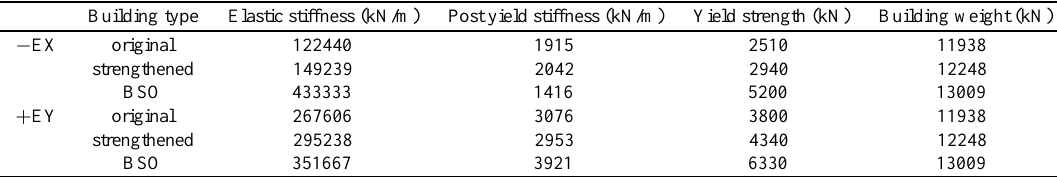
Table 4 Characteristics of equivalent single degree of